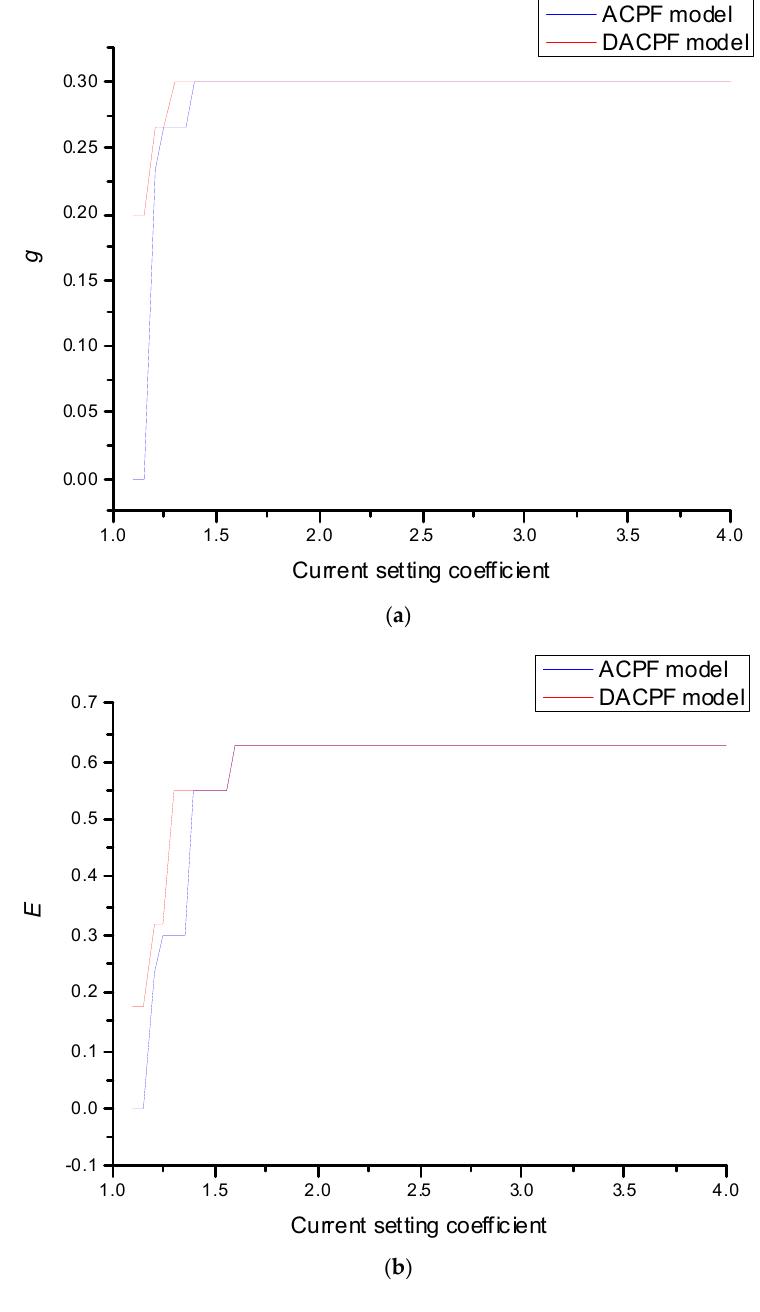
Figure 7. Comparative analysis of the impact of grid current tolerance capability, ( a ) Connectivity; ( b ) Global effective performance.